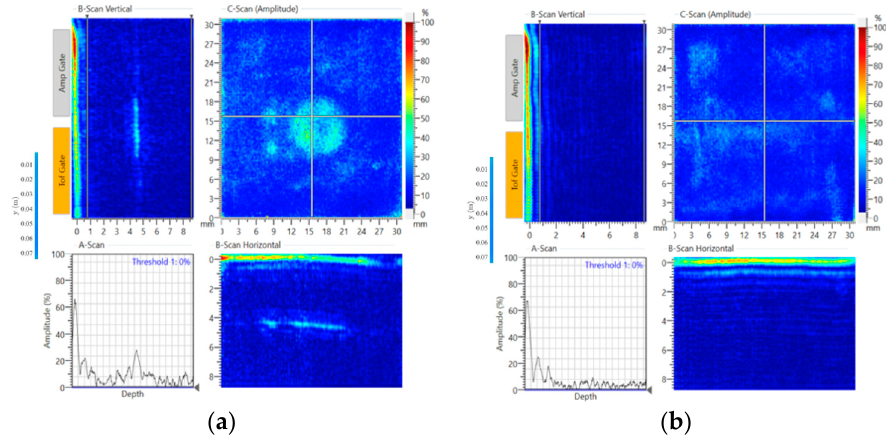
Figure 4. C ‐ Scan results for ( a ) embedded areas, ( b ) non ‐ embedded areas.